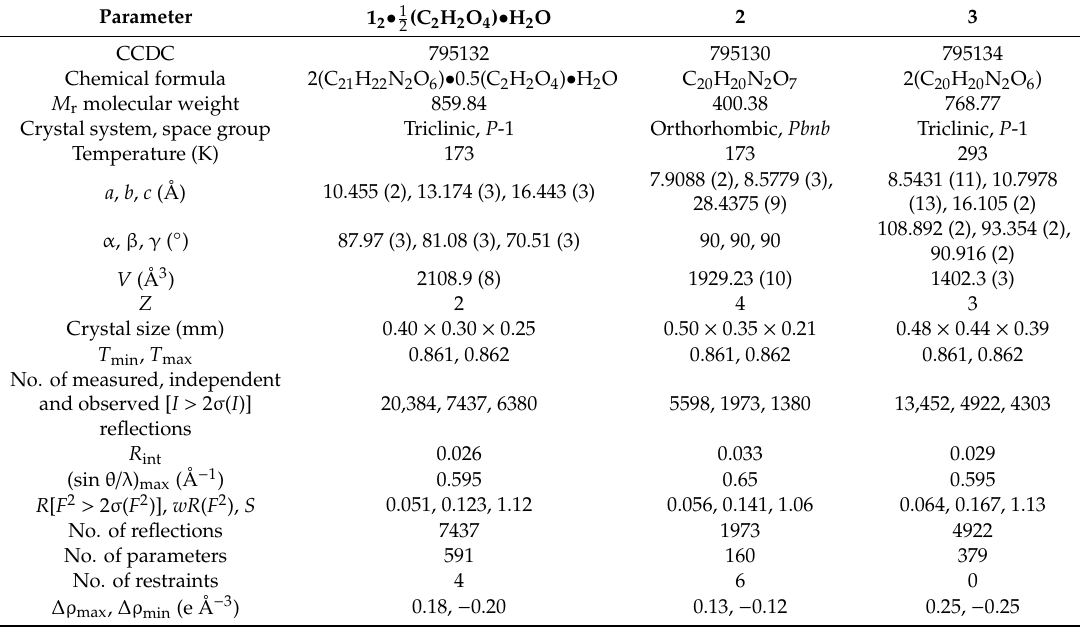
Table 1. Crystallographic data and refinement for 1-3 .